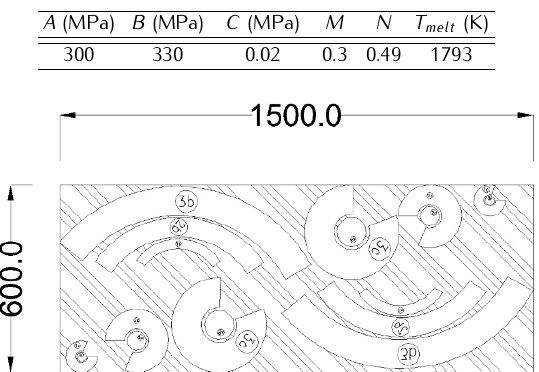
Table 3. Coefficients of Johnson-Cook equation for SA-516 Gr.70 carbon steel.